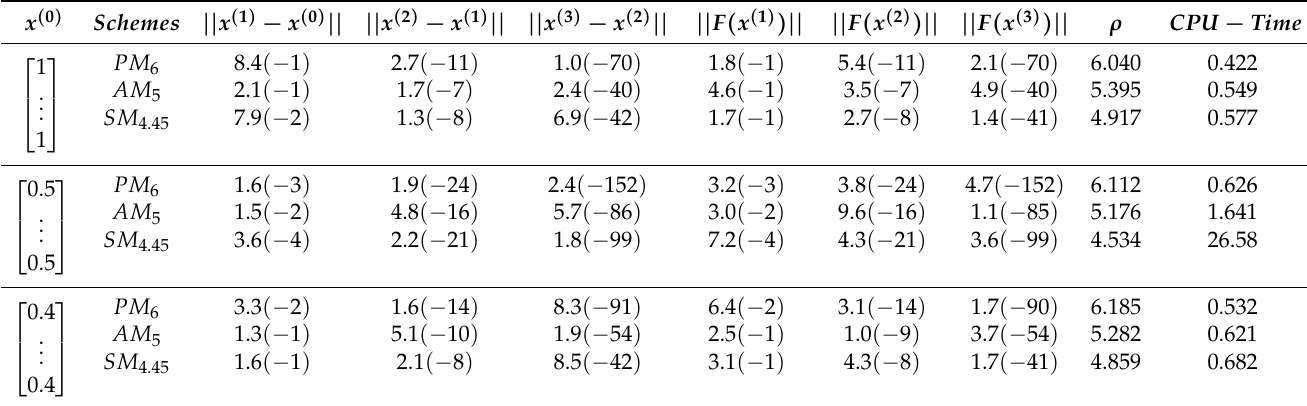
Table 1. Convergence behavior of the schemes for Example 1.